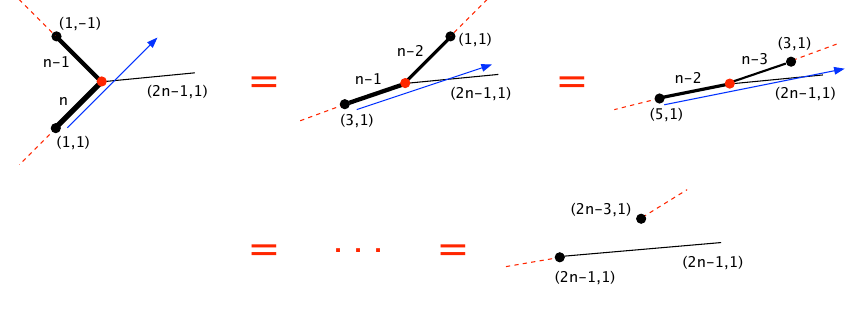
Figure 20 . A compound trivial junction.